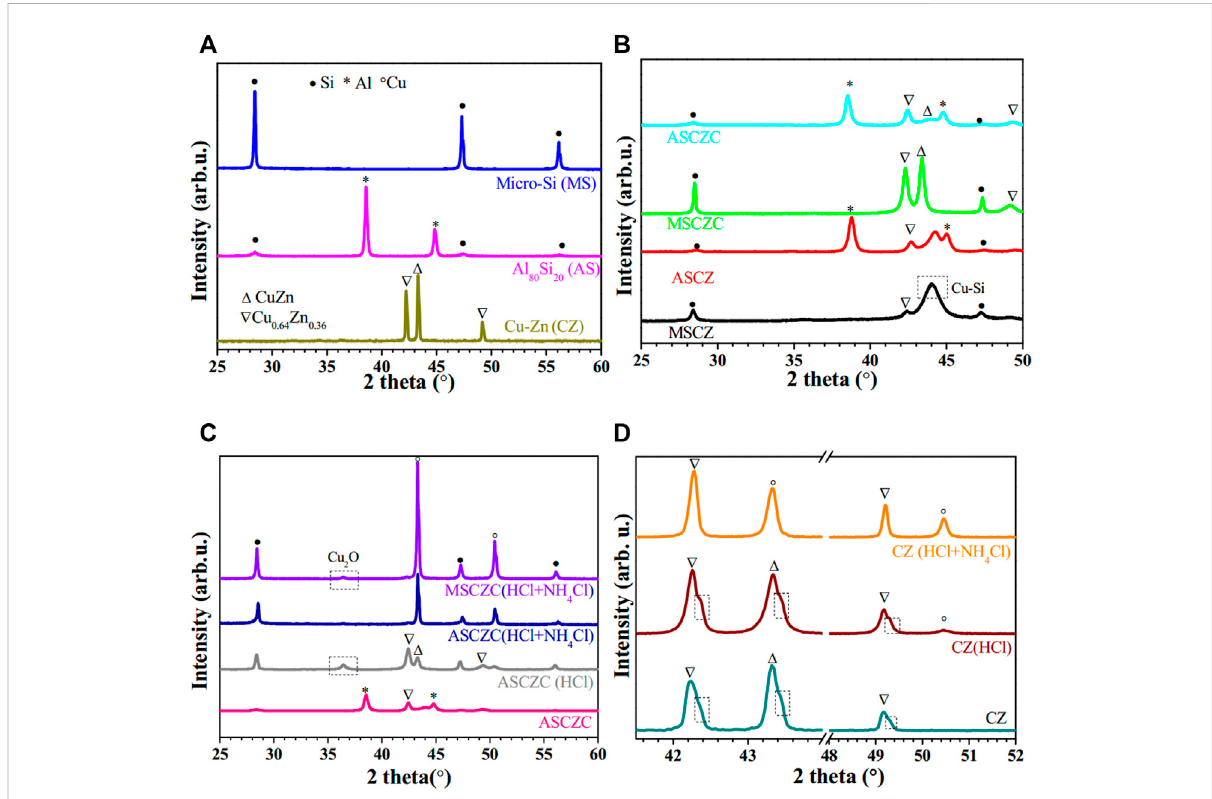
FIGURE 1 XRDpatternsof (A) rawpowder, (B) as-synthesizedcomposites, (C) compositesaftertheetchingprocess(byHClandHCl/NH 4 Cl,respectively), and (D) Cu – Zn alloy before and after